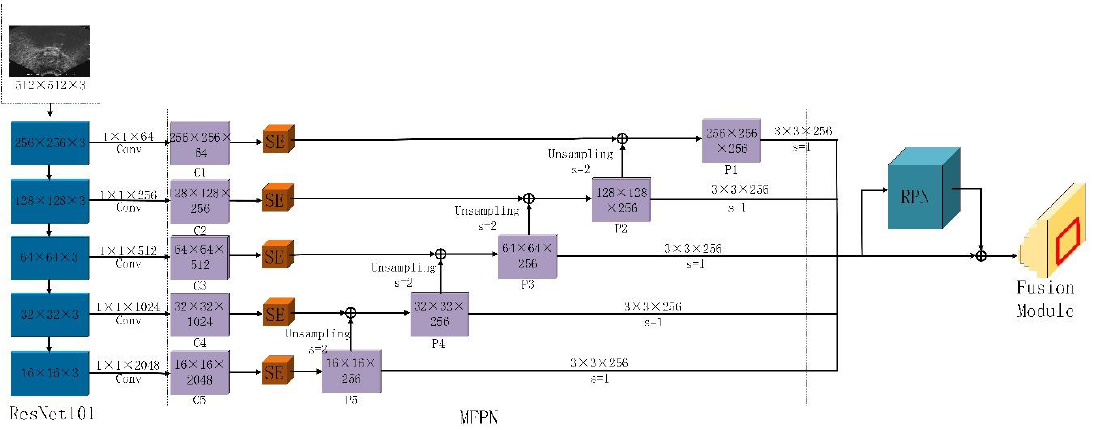
Figure 2. Network structure: The prostate image is the input of the ResNet101 structure. Then, the feature maps (of different sizes) of each layer are inputted into the multi-channel feature pyramid network (MFPN) for feature fusion. The output feature maps are finally inputted into the Region Proposal Networks (RPN) network. The resulting feature fusion module has rich semantic information in the region of interest (ROI).